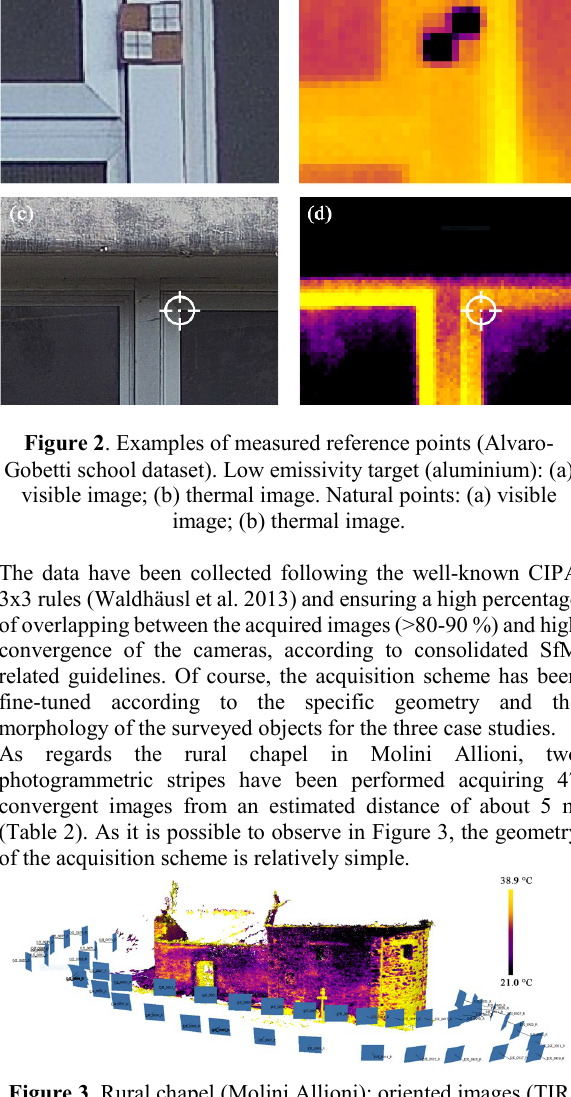
Figure 3 . Rural chapel (Molini Allioni): oriented images (TIR dataset). Table 3 . Estimated GSD: (A) Elva, (B) C. Alvaro-P. Gobetti Comprehensive School, (C) Parabolic arch of